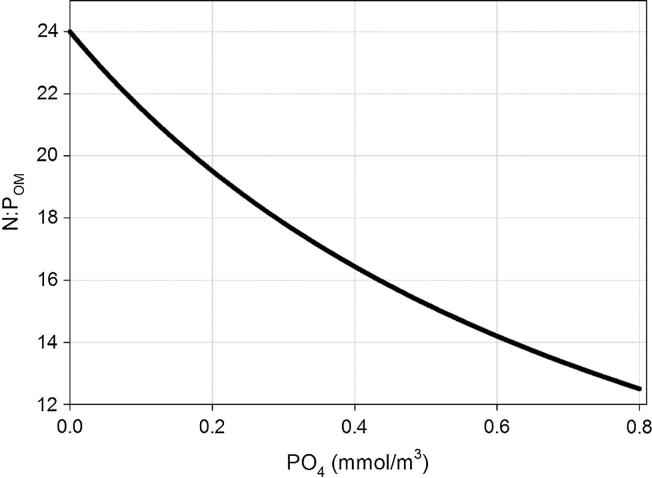
Dependence of the N:POM computed by the LoF formulation (Eq. (3)) versus the waters’ PO4 concentration.